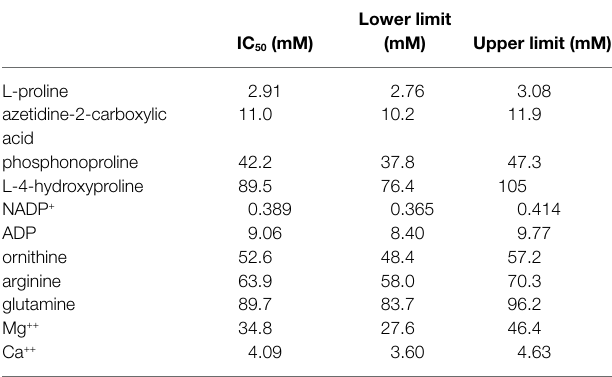
TABLE 2 | Concentrations of selected substances able to inhibit by 50% the activity of Oryza sativa P5C synthetase 2.